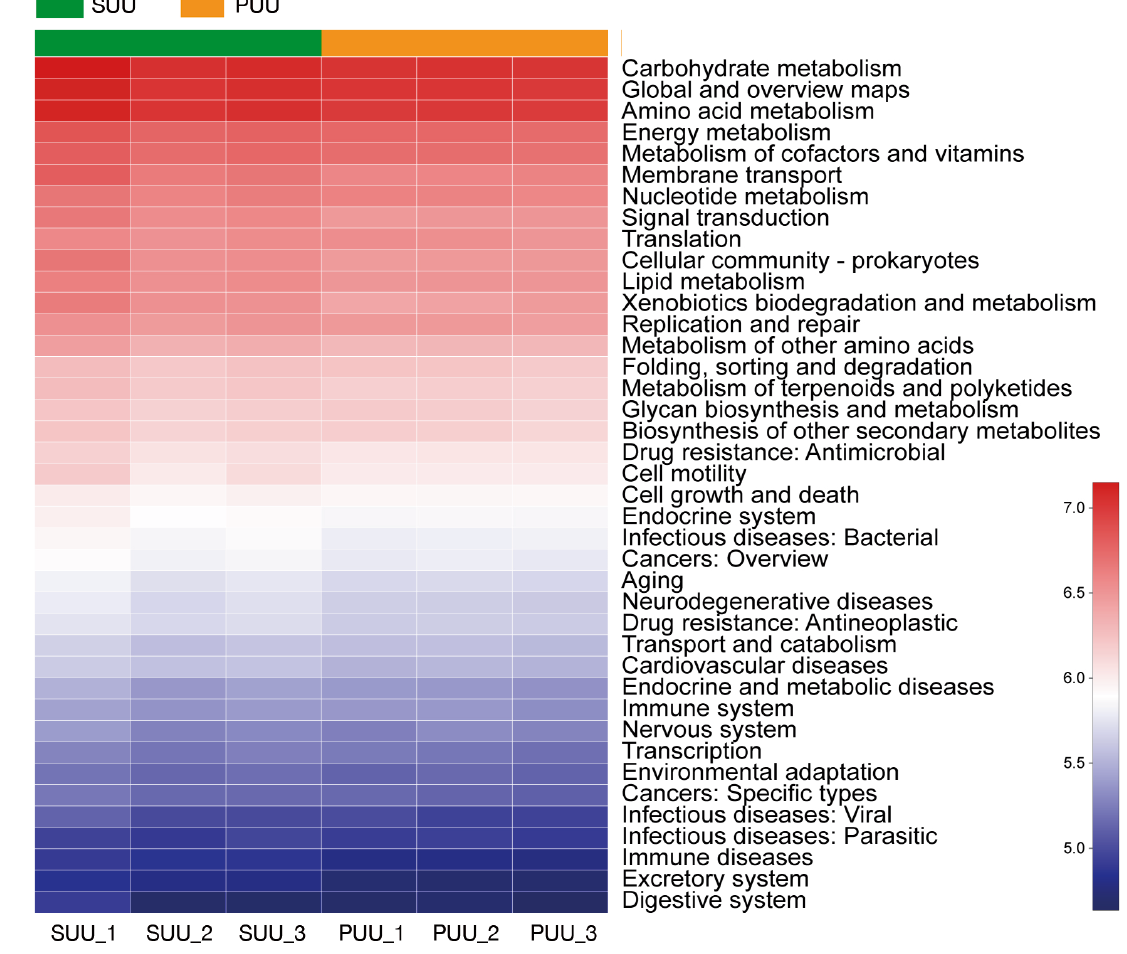
Fig. 7. Heatmap profiles showing the functional categories (KEGG level 2) of bacterial communities in the gut microbiota of Urechis unicinctus as predicted by PICRUSt analysis. Rows represent the 40 KEGG orthology (KO) functions, columns repre- sent the 6 samples (SUU: coastal, PUU: pond polycultured), and the color intensity in the heatmap represents the relative abundance (log) of functional